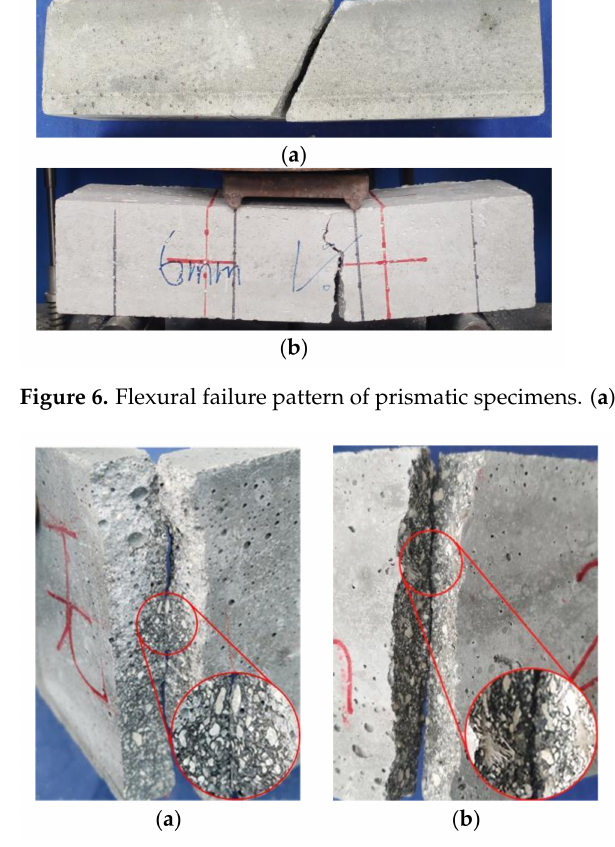
Figure 7. Figure 7. Four-point bending failure pattern of thin-slab specimens. ( a ) NF, ( b ) PVA.